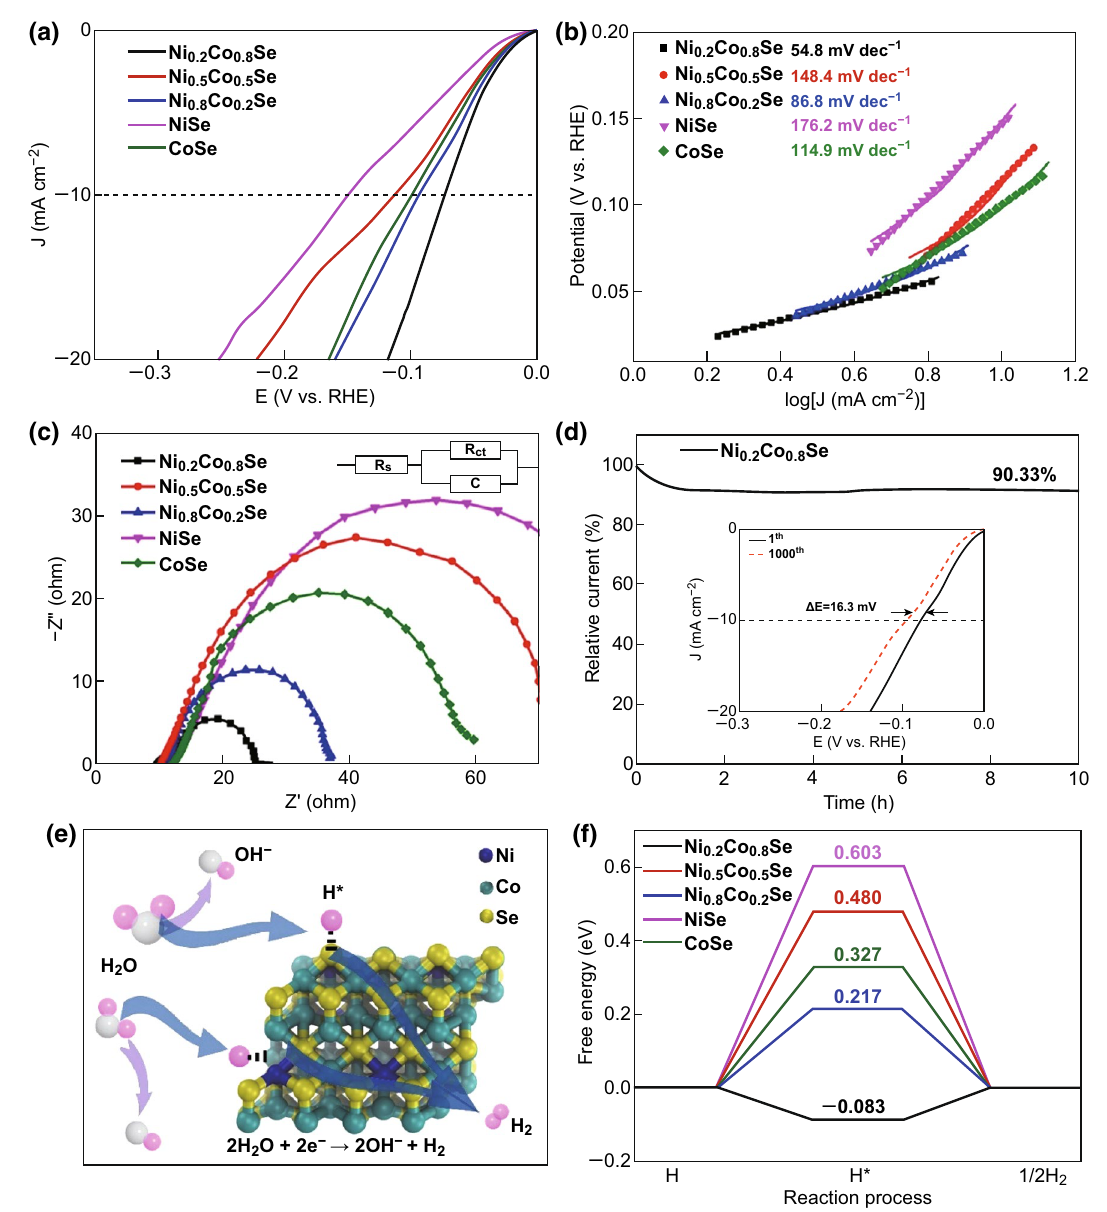
Fig. 5 a HER polarization curves of Ni 0.2 Co 0.8 Se, Ni 0.5 Co 0.5 Se, Ni 0.8 Co 0.2 Se, NiSe, and CoSe obtained at a scan rate of 10 mV s −1 in 1.0 M KOH. b Corresponding Tafel plots. c EIS Nyquist plots, where R s represents the electrolyte resistance, C represents the double‑layer capaci‑ tance, and R ct represents the charge‑transfer resistance. d HER polarization curves of the Ni 0.2 Co 0.8 Se electrode tested after 1 and 1000 CV cycles. The inset shows the chronoamperometric response of Ni 0.2 Co 0.8 Se at 10 mA cm −2 . e Schematic of the HER at the Ni 0.2 Co 0.8 Se active interface in the alkaline environment. f Adsorption free energy diagram for the Volmer reaction